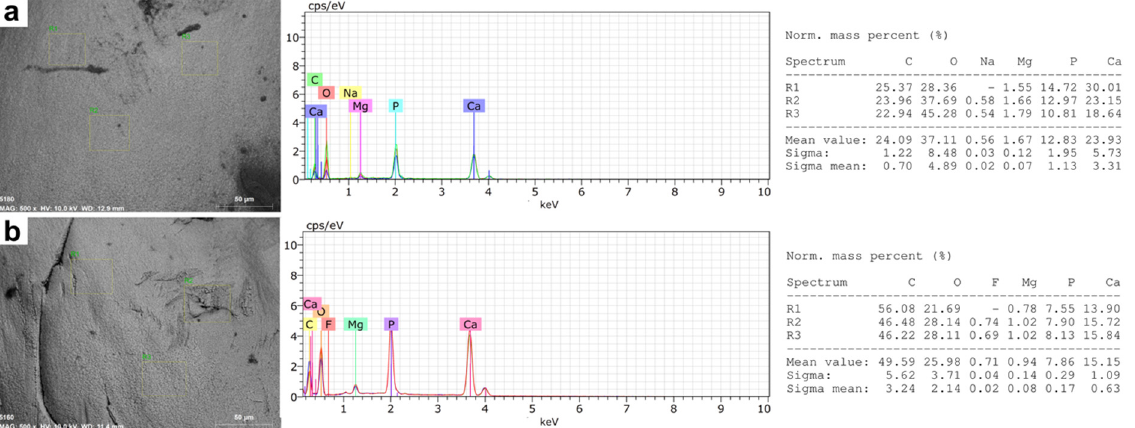
Figure 3. Elemental Microanalysis in teeth of rainbow trout (Oncorhynchus mykiss) . ( a ) Farmed fish. ( b ) Wild fish. BSD image, 500× magnification. Scanning Electron Microscope (Hitachi SU3500, Tokyo, Japan) coupled to XFlash ® Detector 410 and Quantax Esprit 1.8.1 Software controller (Bruker, Germany). The percentages of Ca and P between the samples of healthy fish (Ca: 23.78%; P: 11.7%; p = 0.001) and wild fish (Ca: 17.63%; P: 8.32%; p = 0.001), and in the latter an increase